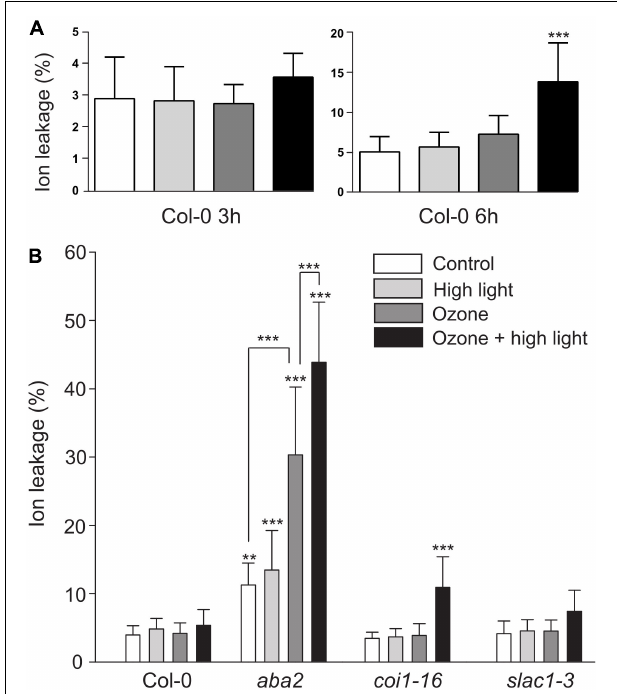
FIGURE 9 | Cell death after combined O 3 and HL. (A) Cell death quantified with ion leakage after 3 or 6 h of HL, O 3 (350 nL L - 1 ) or combined treatment (growth condition Helsinki-3). (B) Plants treated with 2 h of HL, O 3 or combined treatment followed by 4 h in control conditions and quantification of cell death. The average of three biological replicates are shown ( N = 15); error bars depict standard deviation. One-way or two-way ANOVA with Tukey’s test was used for statistical analysis and depicts significant differences compared to Col-0 control (* P < 0.05; ** P < 0.01; *** P <